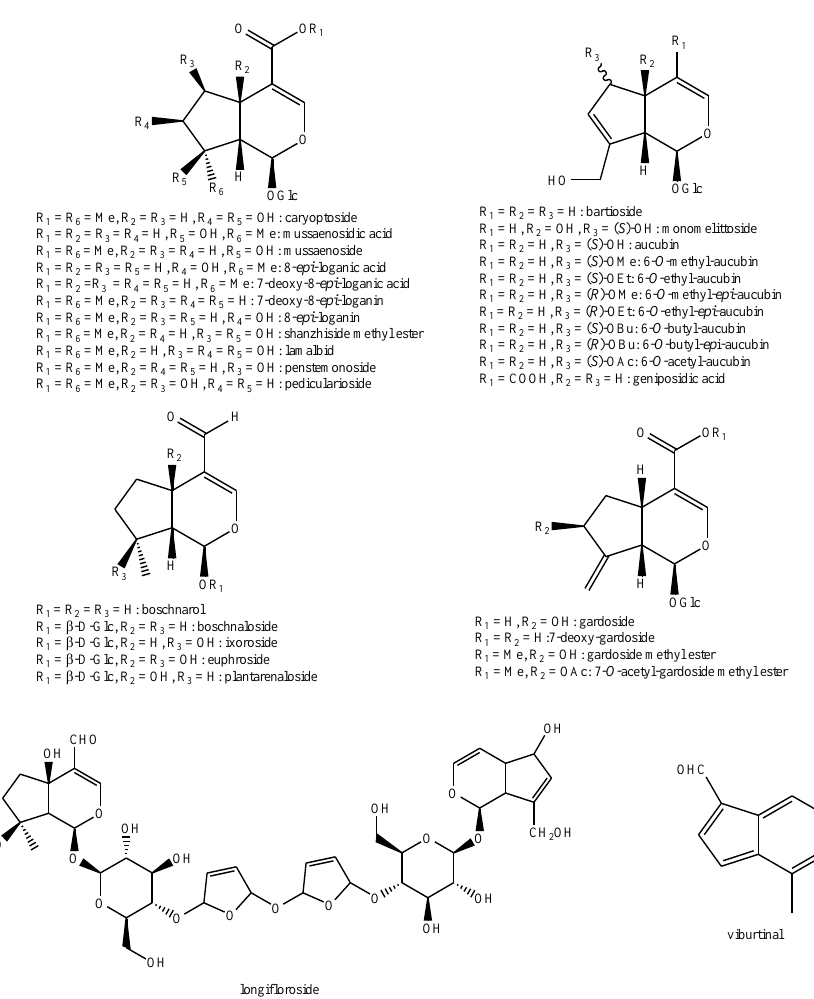
Figure 15. Iridoids identified in Pedicularis species—part 1. Plants 2019 , 8 , x FOR PEER REVIEW